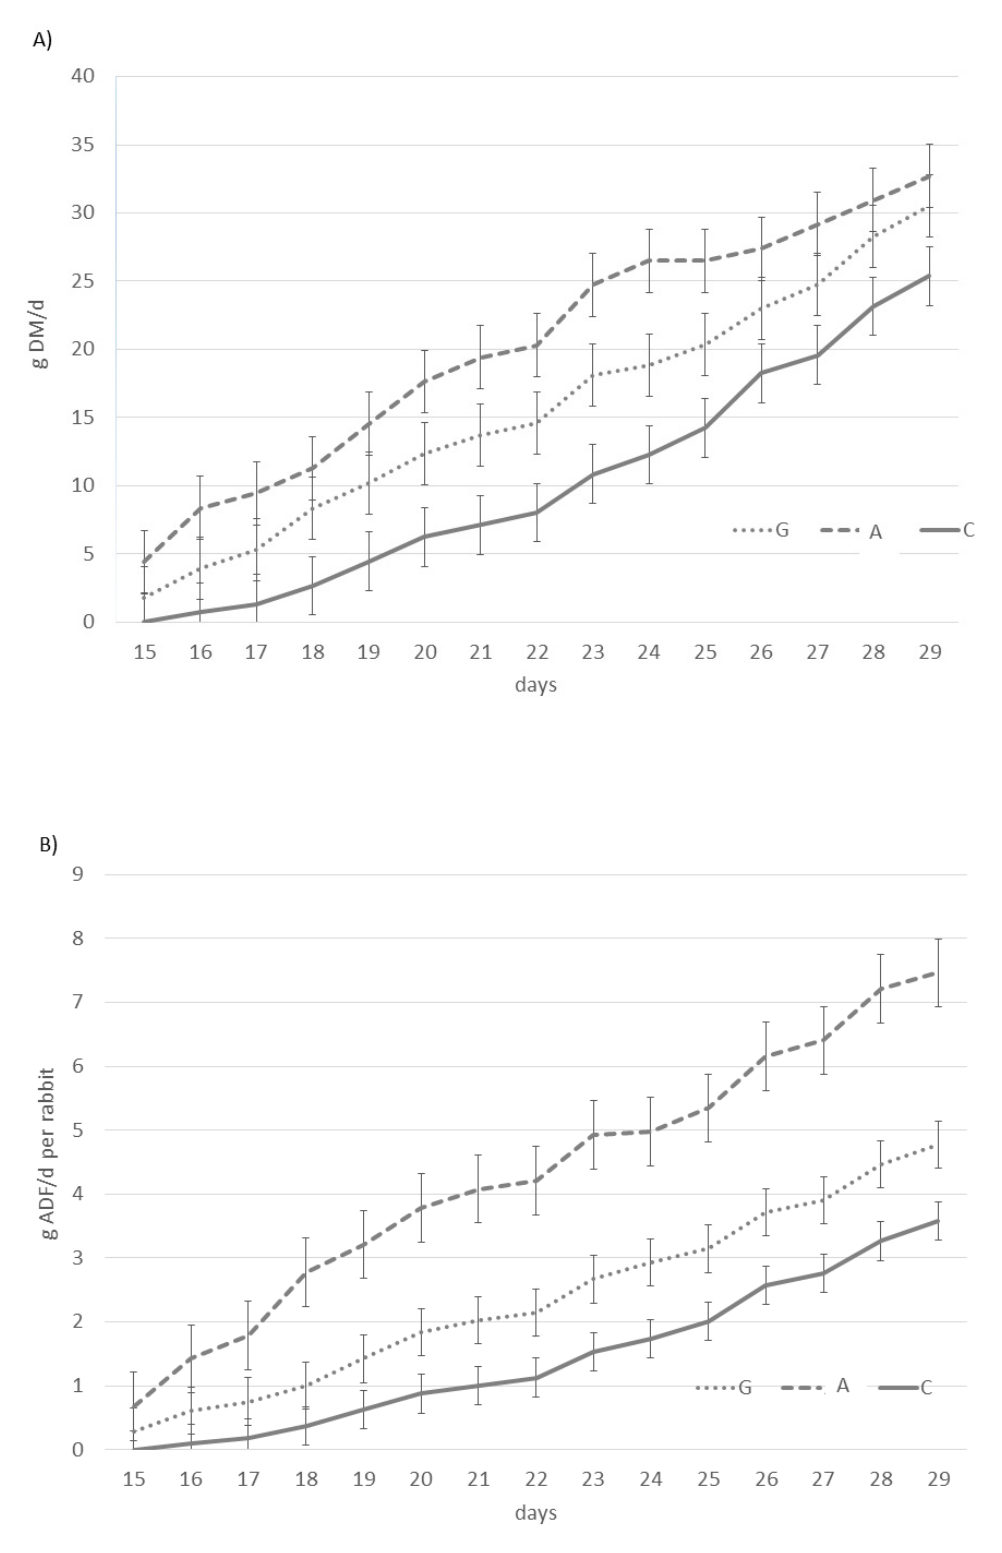
Figure 2. Total feed intake on a dry matter (DM) basis ( A ) and acid detergent fiber (ADF) intake ( B ) of young rabbits from 15 to 30 days of age. The dotted line represents rabbit fed pelleted feed + fresh grass (G group); the dashed line represents rabbit fed pelleted feed + dehydrated alfalfa (A group); the solid line represents rabbit fed pelleted feed (C